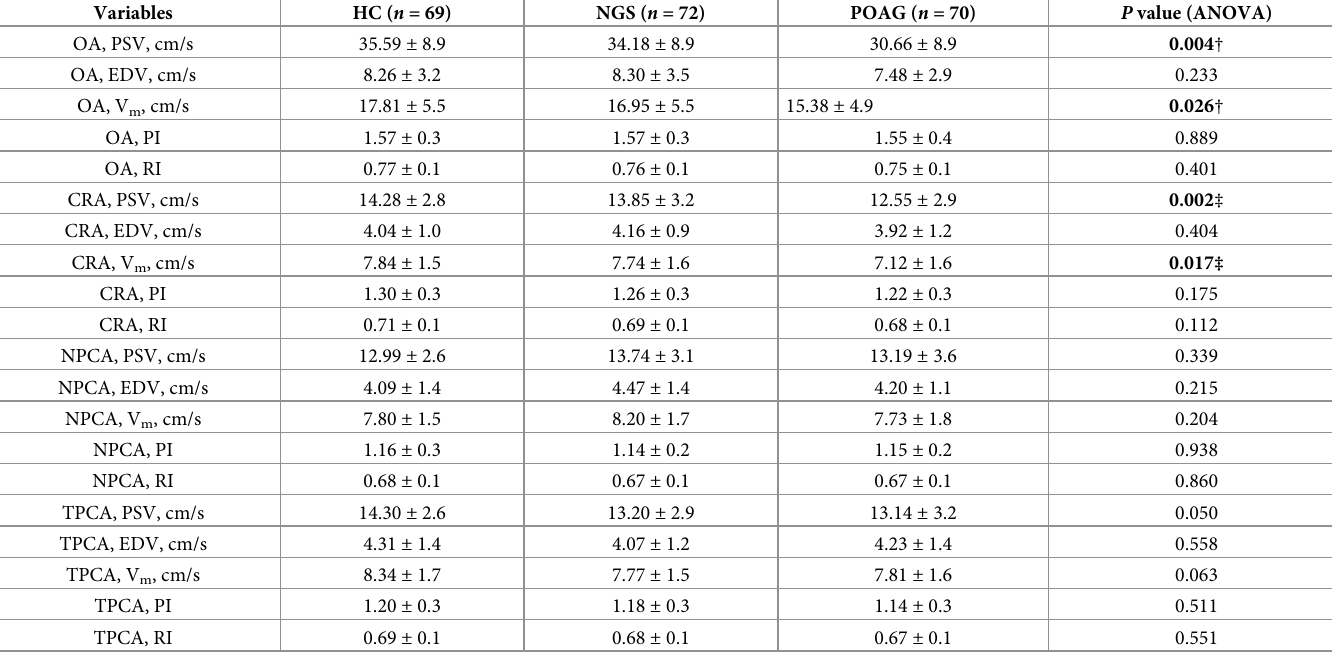
Table 2. Ocular blood flow biomarkers in orbital vessels obtained using color Doppler Imaging device (mean ± one standard deviation, SD) and the results of ANOVA test ( P value).